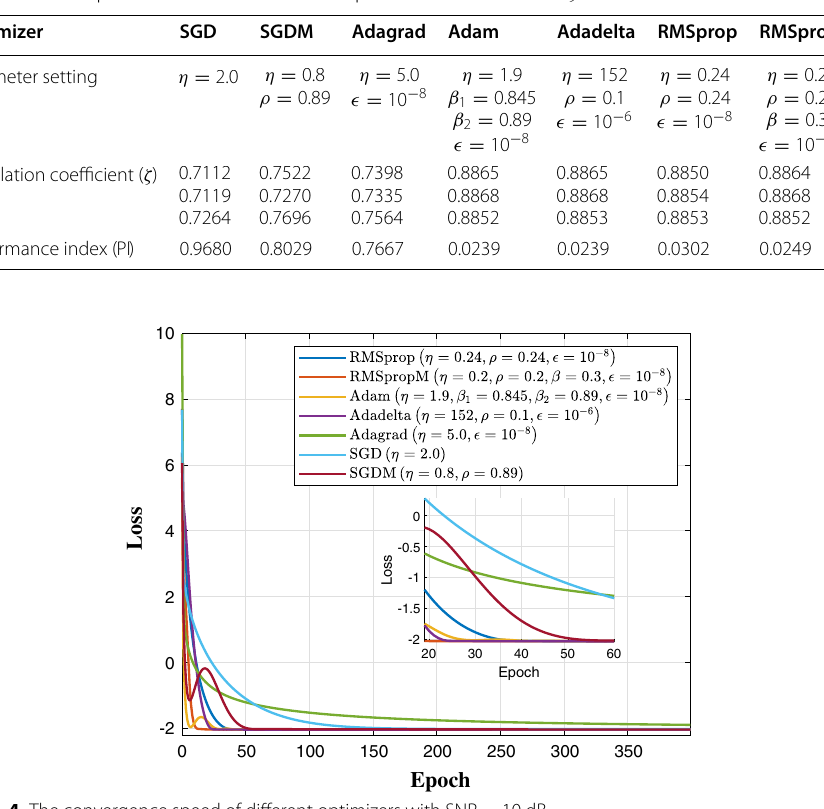
Fig. 4 The convergence speed of different optimizers with SNR